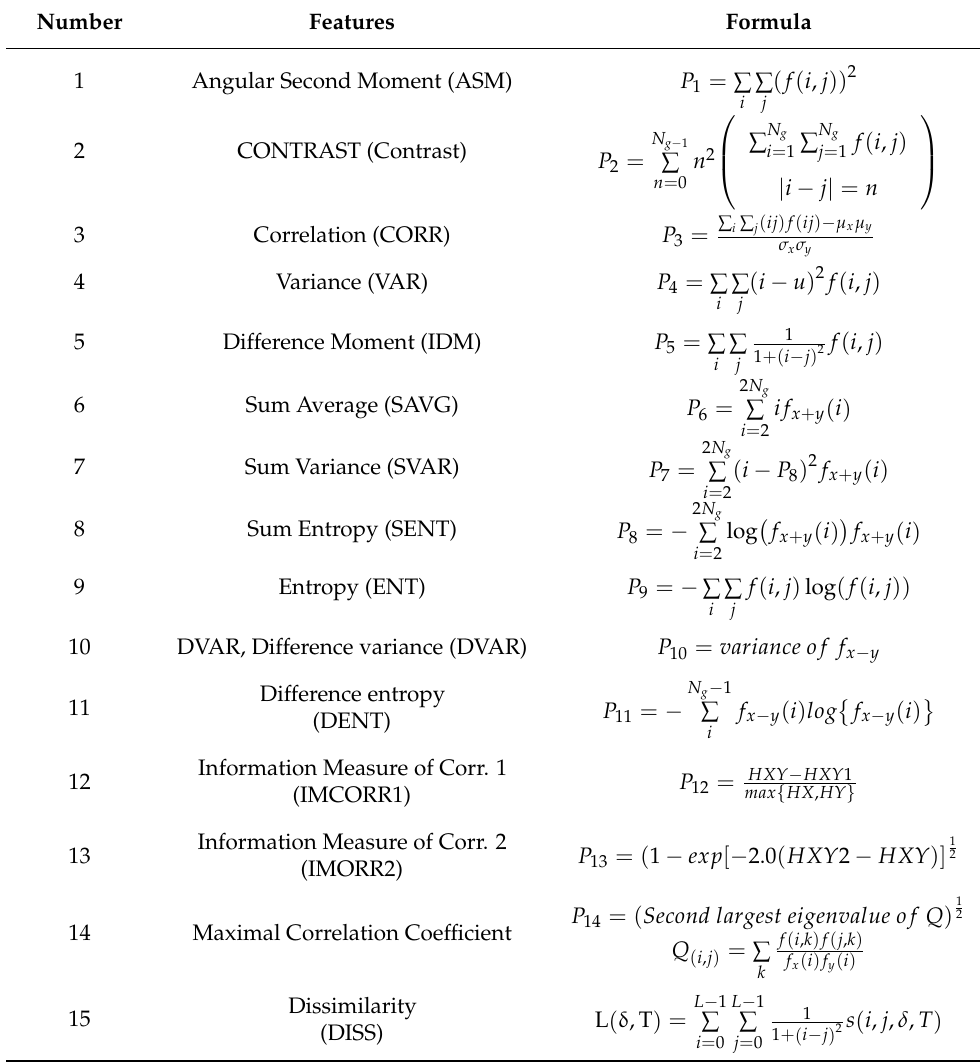
Table A3. GLCM indices